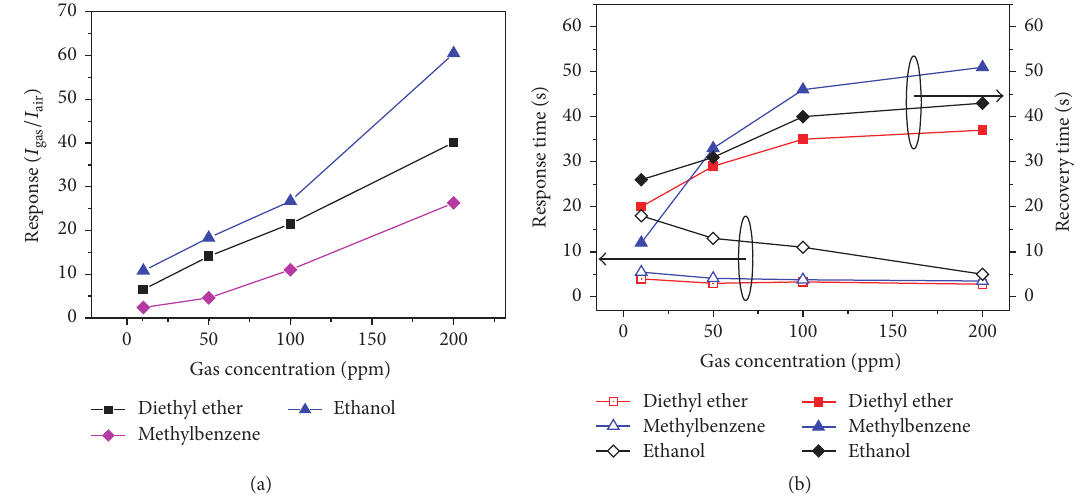
Figure 6: (a) Gas-sensing responses and (b) response and recover times of the ZnO-based gas sensor to target